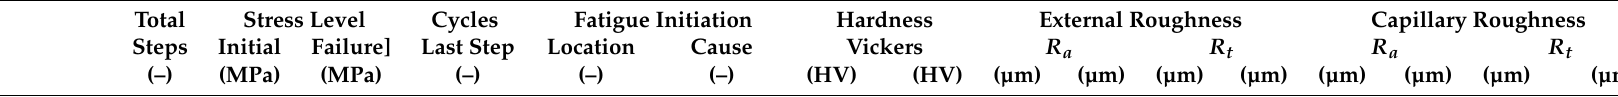
Table 1. Summary of Ti-6Al-4V specimens of four-point bending fatigue tests, hardness and roughness measurements. Standard deviation (STD) is given in between round brackets on the right of the average (AVG) value: AVG.